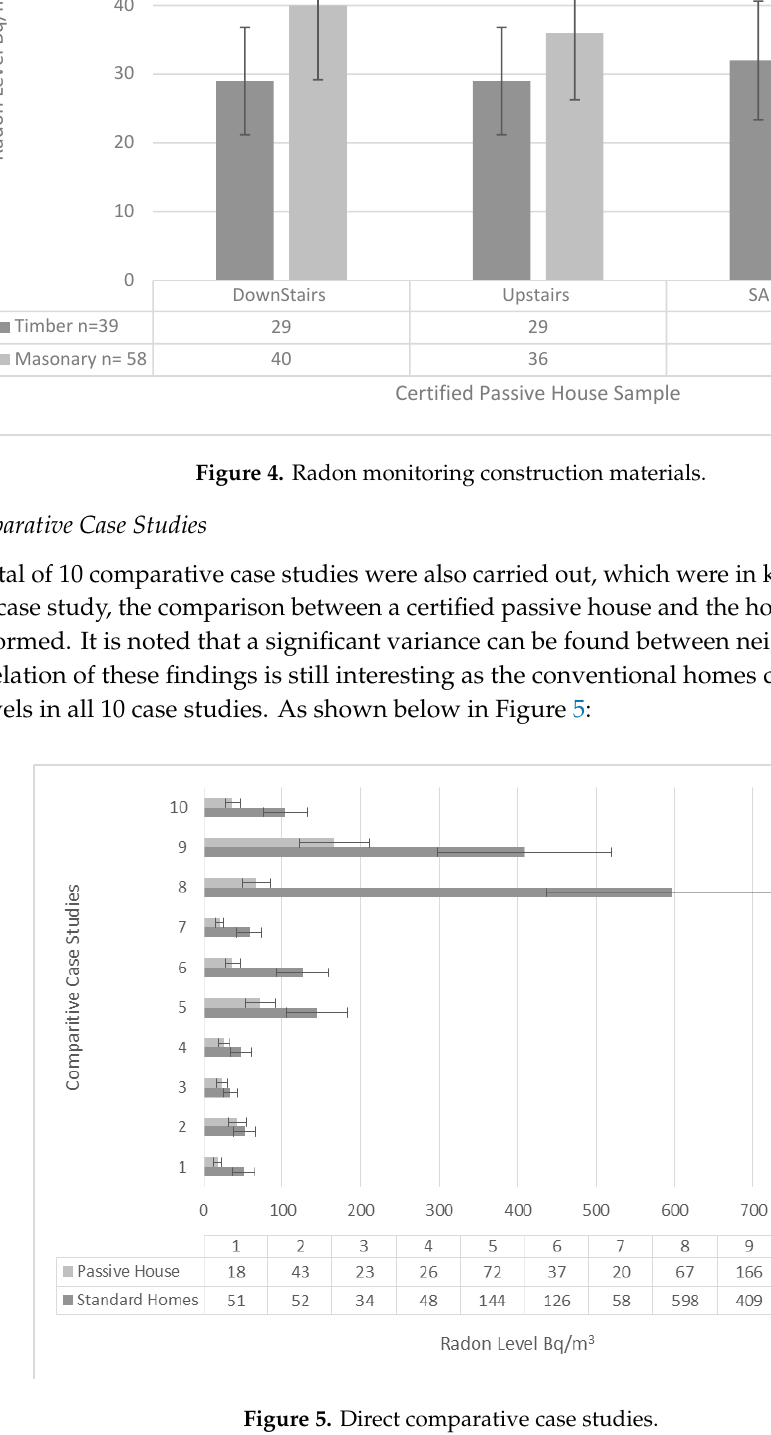
Figure 6. Passive House Retrofit standard (EnerPHit) comparison .